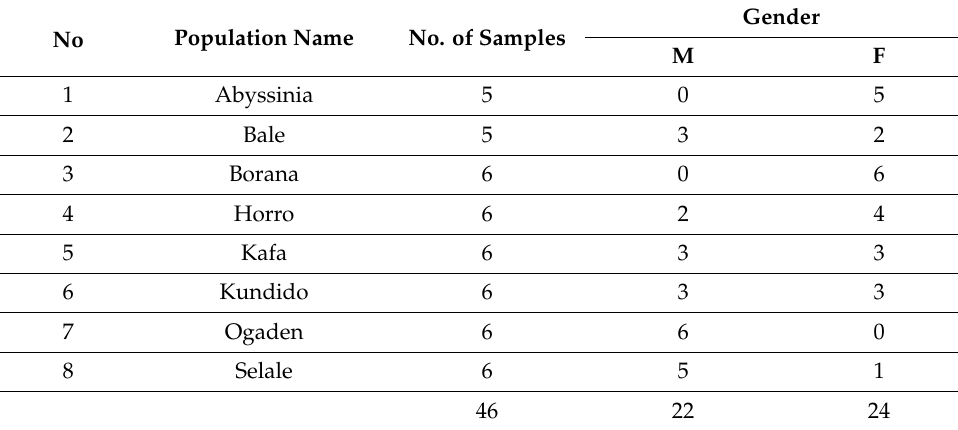
Table 2. Population group and number of samples genotyped by